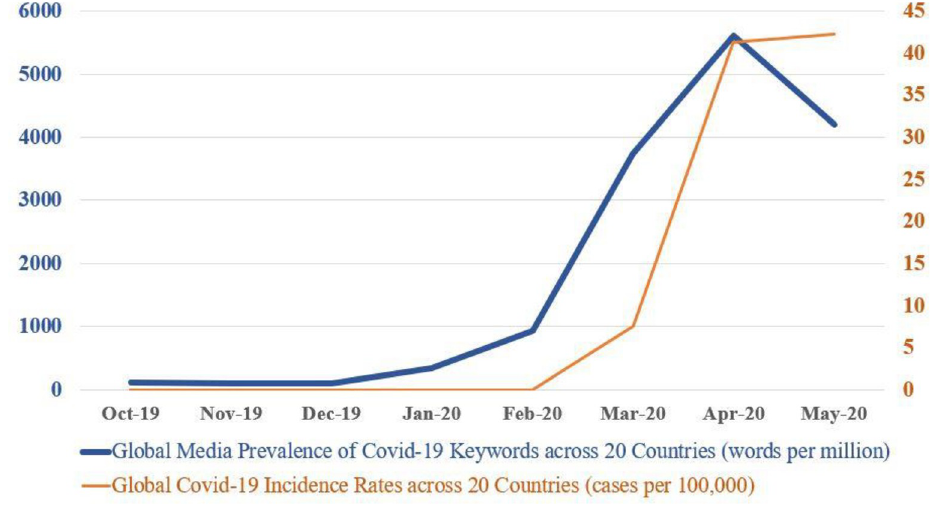
Fig 1. Volume of global Covid-19 narratives & Covid-19 incidence rates. Prevalence of 10 virus-related keywords (Coronavirus, Covid-19, Covid, nCoV, SARS-CoV-2, Wuhan Virus, Virus, Disease, Epidemic, Pandemic) experienced exponential growth from a baseline of 100 words per million in October 2019 to 5500 words per million in April 2020 —a 55-fold increase. The prevalence of global Covid-19 narratives dovetails the global Covid-19 incidence rate across 20